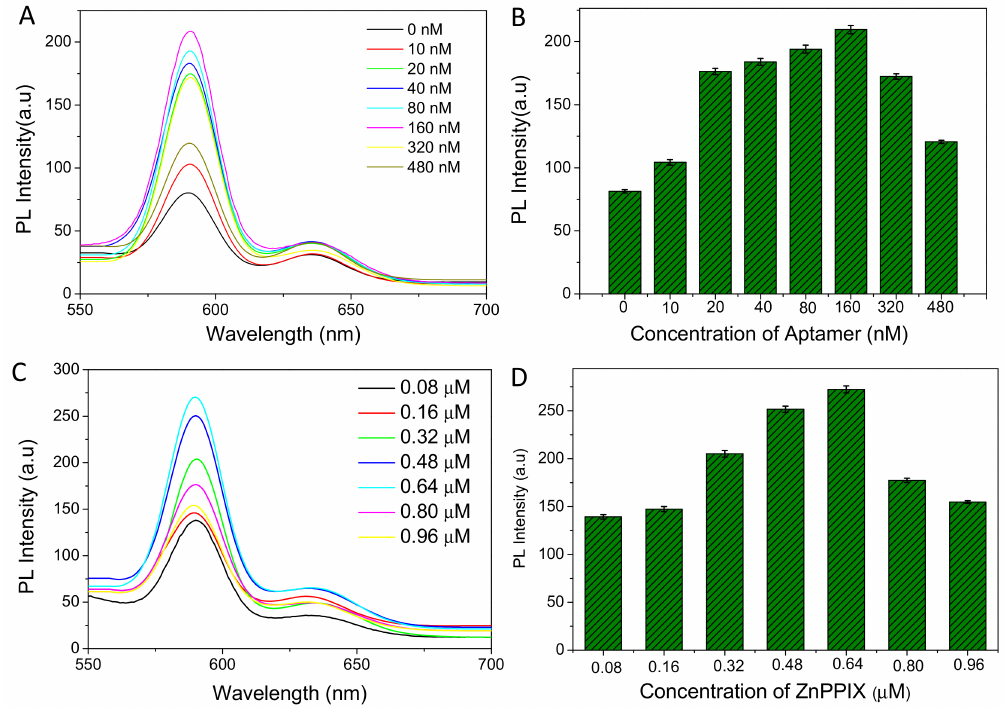
Figure 3. ( A ) The emission spectra of aptamer-ZnPPIX system containing 0.64 µ M ZnPPIX, 1 nM OTA and different concentration of aptamer; ( B ) The relationship of fluorescence response and aptamer concentration; ( C ) The emission spectra of aptamer-ZnPPIX system containing 160 nM aptamer, 1 nM OTA and different concentration of ZnPPIX probe; ( D ) The relationship of fluorescence response and ZnPPIX concentration. ( λ ex = 430 nm, 10 mM HEPES (pH 7.0, containing 50 mM